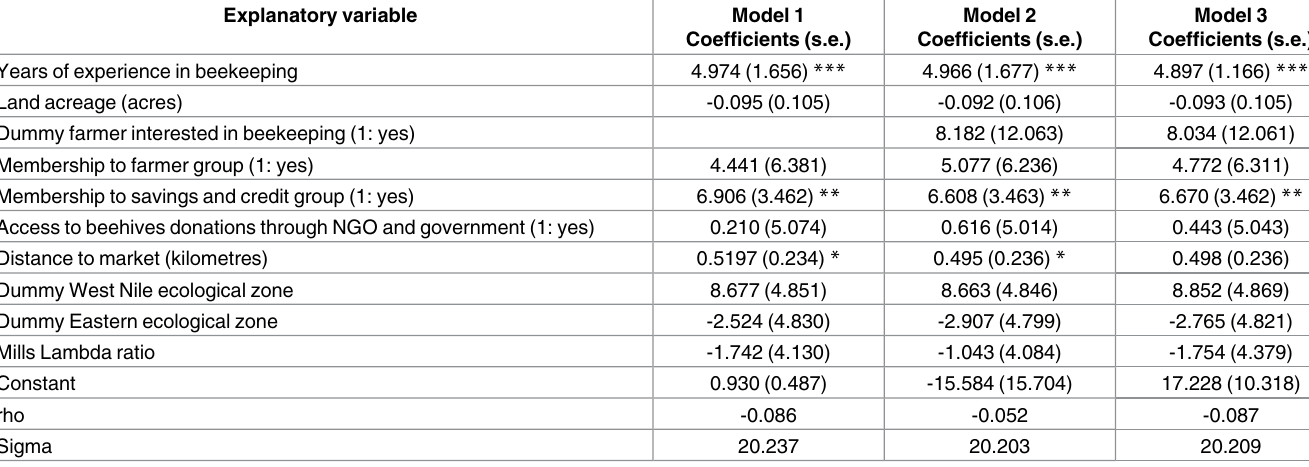
Table 6. Step 2: Estimation of beekeeping adoption intensity.